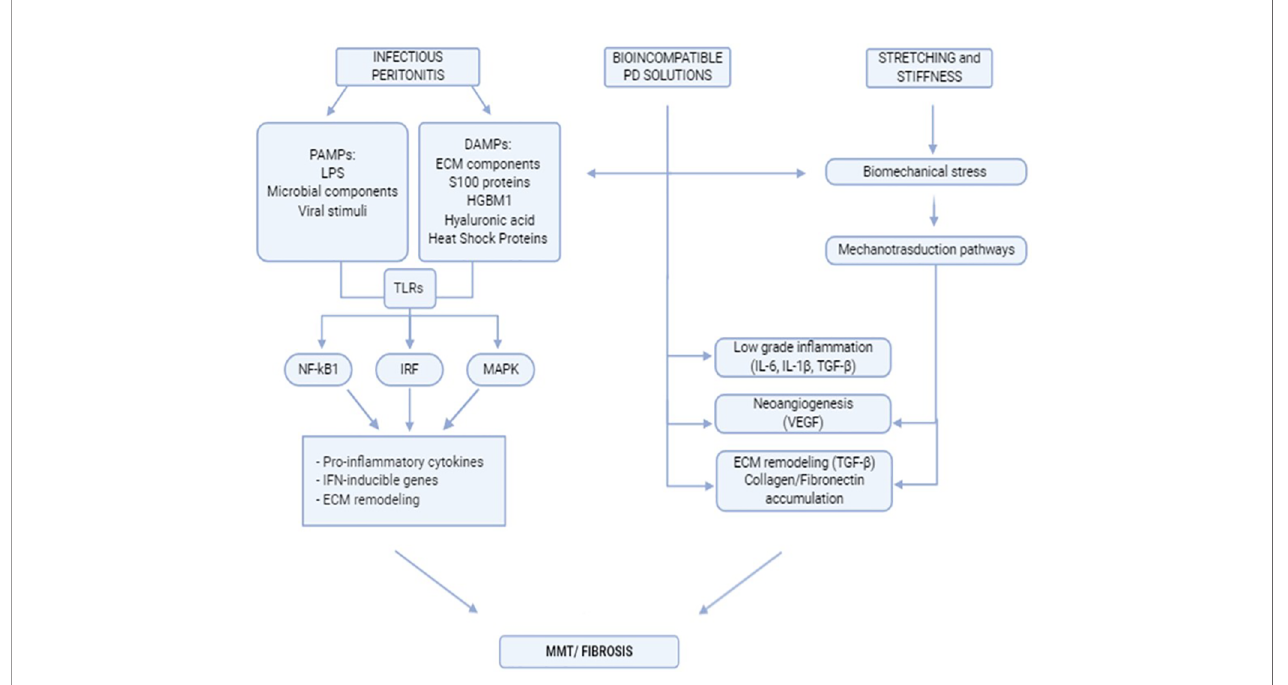
FIGURE 1 | Flowchart indicating the main extracellular stimuli promoting peritoneal fi brosis and subsequent mesothelial cell